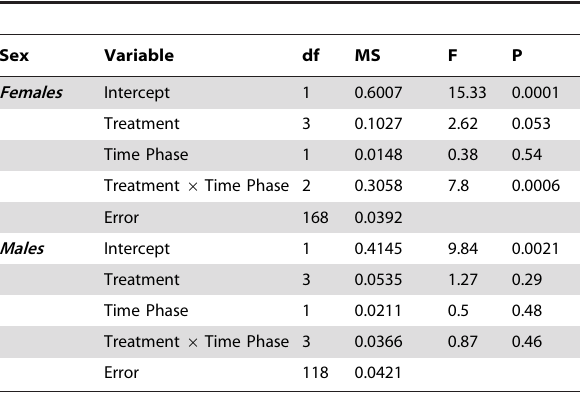
Table 6. C. longiareolata , ANCOVA of the effect of treatment and time phase (adult emergence) on